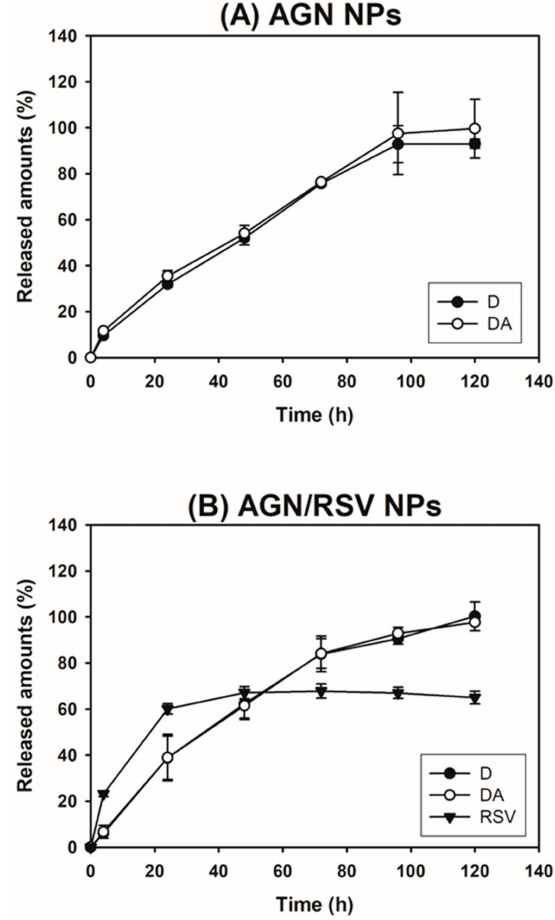
Figure 4. The release data of AGN NPs (D and DA) and AGN/RSV NPs (D, DA, and RSV). The cumulative released amounts of D, DA, and RSV from ( A ) AGN NPs and ( B ) AGN/RSV NPs are plotted. Data are shown as the mean ± SD ( n =